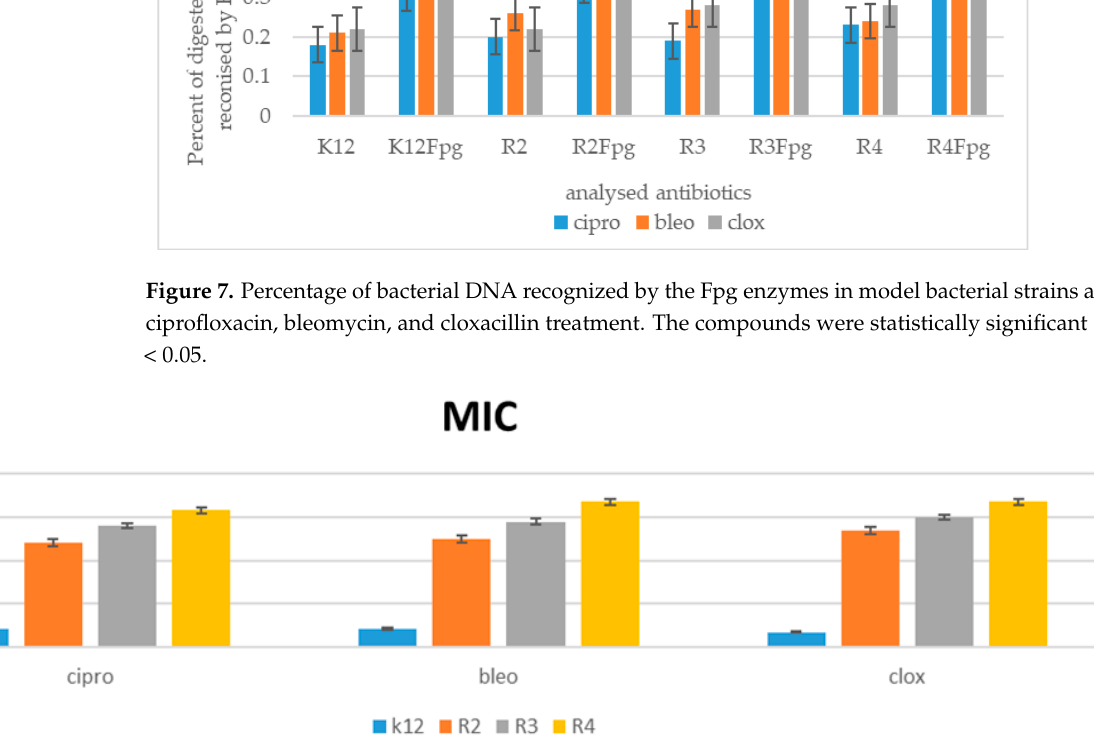
Figure 7. Examples of MIC with model bacterial strains K12, R2, R3, and R4 for studying the antibiotics ciprofloxacin (cipro), bleomycin (bleo), and cloxacillin (clox). The x -axis features antibiotics used sequentially. The y -axis features the MIC value in µg/mL − 1 .